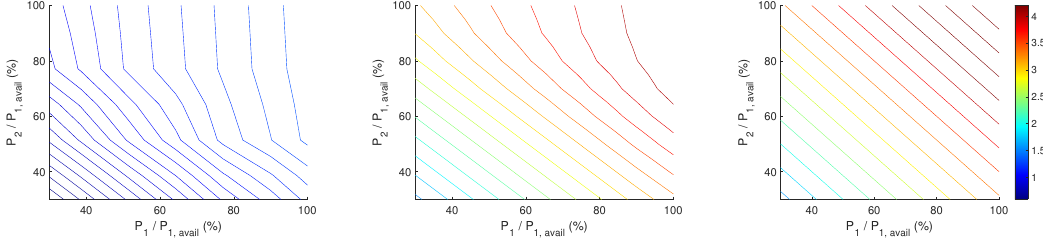
Figure 8. Contours of normalised power output of turbine array. Ambient mean wind speed is 8, 12 and 16 m/s from left to right. Default wind conditions are mean wind speed of 8 m/s, turbulence intensity of 7%, and wind direction of 0 degrees, in which direction is aligned with turbine array. Turbine interspace is